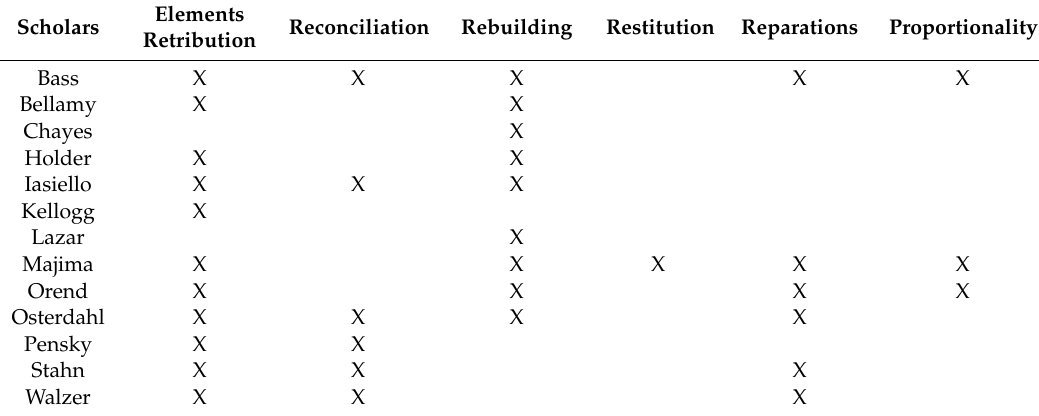
Table 1. Scholars and elements of the jus post bellum